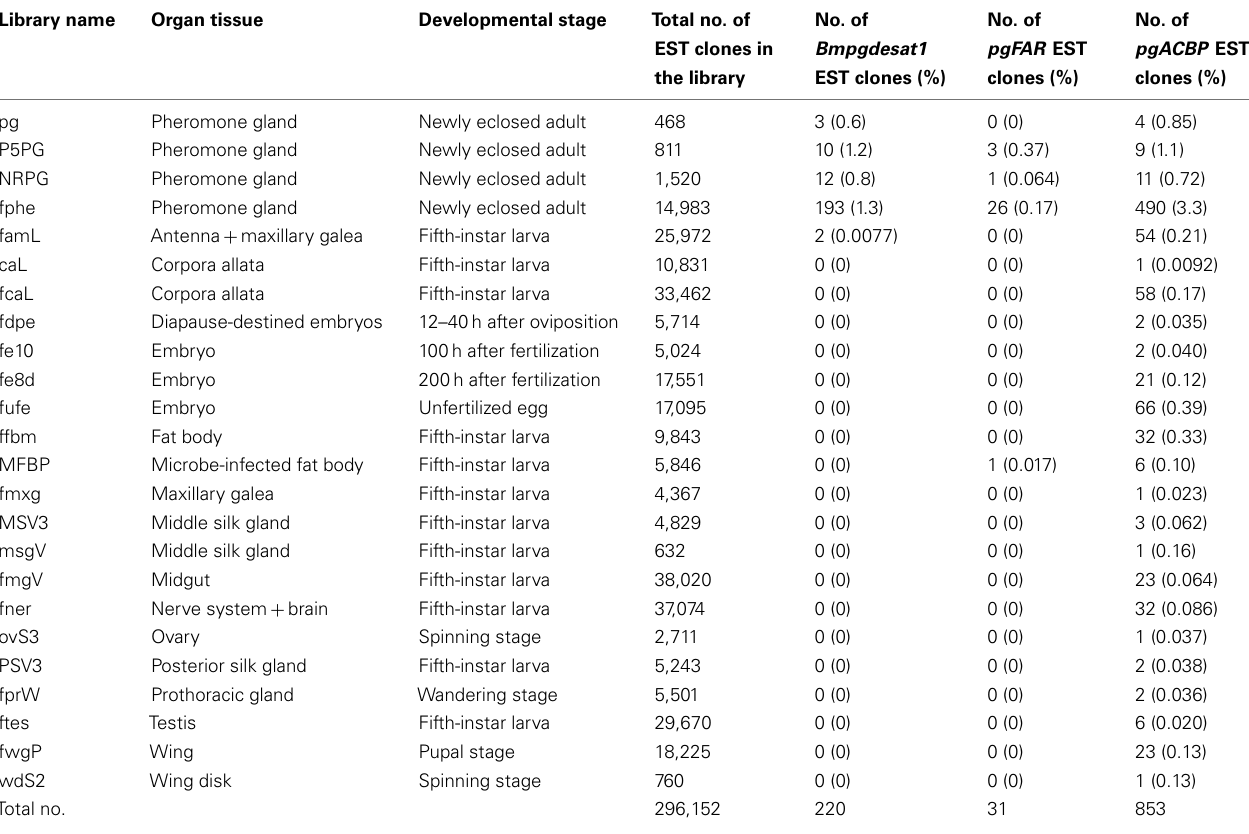
Table 2 |The relationship between individual genes and the frequency of their identified EST clones amongst the cDNA libraries that comprise the B. mori EST database.